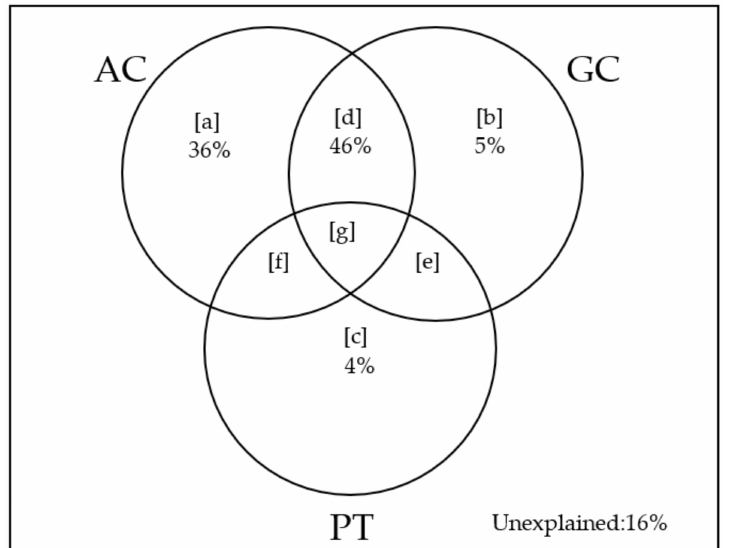
Figure 2. Variation partition analysis of the effects of AC, GC and PT on GPR. The variations in the GPR explained by the three factors are expressed in percentages. Amylose content (AC) [a], gel consistency (GC) [b], pasting temperature (PT) [c] and shared fractions [d], [e], [f], [g] are provided separately. Negative values are not